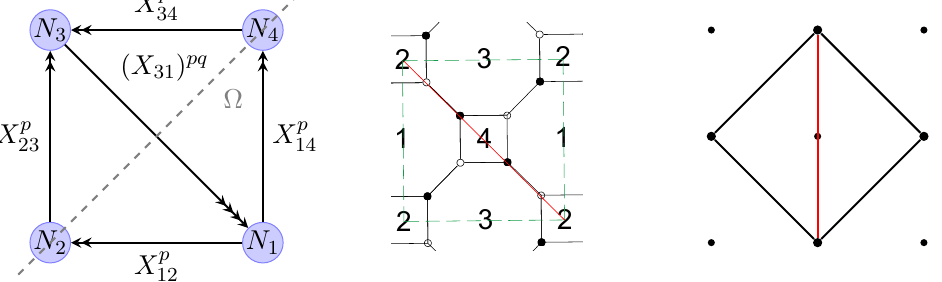
Figure 20. The Seiberg dual, or magnetic, phase C = Z 0 shown on the left, while the corresponding dimer is on the right.